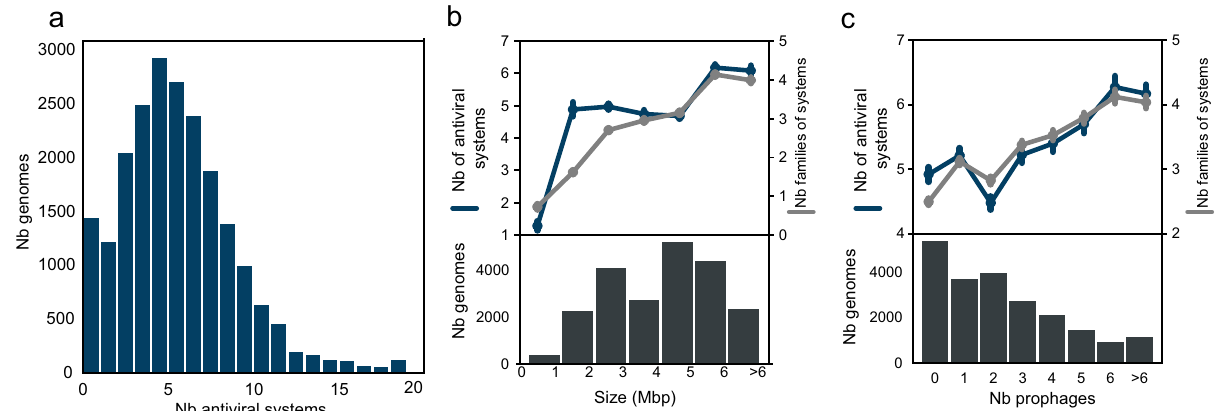
Fig. 2 Distribution of antiviral systems in prokaryotic genomes. a Distribution of the total number of antiviral systems per genome. The x -axis was cut at 20 for data visualization purposes. Max number is 57 ( Desulfonema limicola ). b Average number of antiviral systems (blue) and number of families of antiviral systems (gray) are correlated with genome size (two-sided Spearman, ρ = 0.25 and ρ = 0.44, both p -values < 0.0001 on all sizes; ρ = 0.27 and ρ = 0.30, p -value < 0.0001 for the 2 Mbp – 5 Mbp interval) (CI = 95%). Bottom plot, distribution of the genome size. c Average number of antiviral systems (blue) and number of families of antiviral systems (gray) are correlated with number of prophages (two-sided Spearman, ρ = 0.16 and ρ = 0.27, both p -values < 0.0001) (CI = 95%). Bottom plot, distribution of the number of prophages in 113,955 different antiviral systems, comprised of 301,372 genes (Supplementary Data 5 and 6). On average prokaryotes encode fi ve antiviral systems (5.2). The number of antiviral systems per